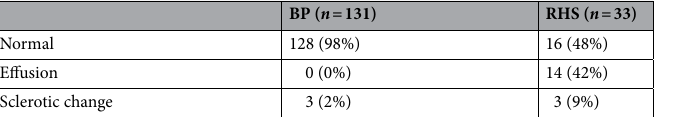
BP ( n = 131) RHS ( n = 33)